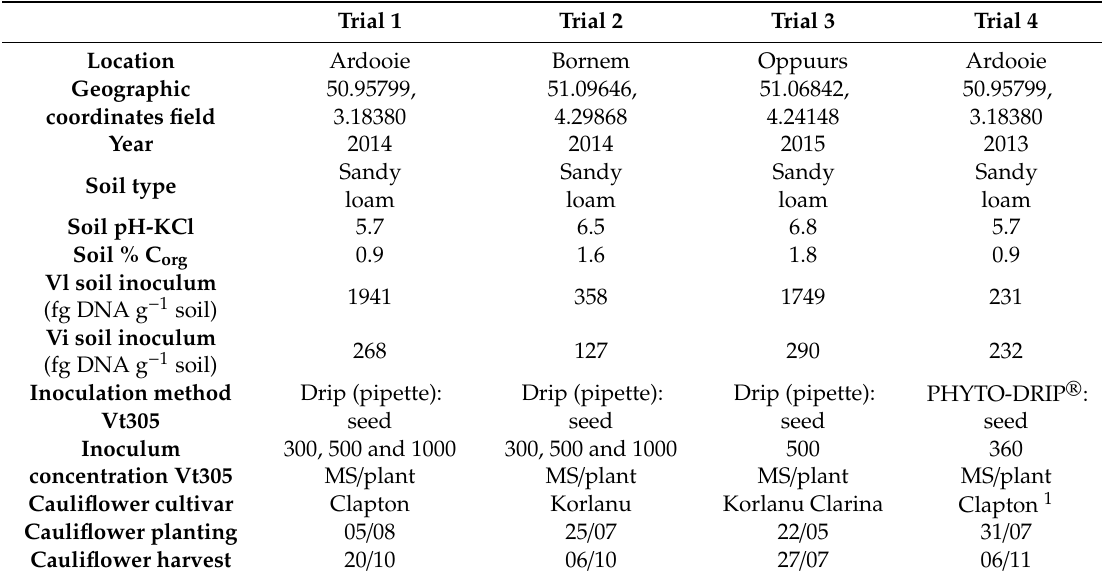
Table 4. Overview of the field trials in which the e ff ect of artificial inoculation of cauliflower plants with V. isaacii Vt305 on Verticillium wilt was tested. For each experiment, the location, the soil characteristics, the amount of soil inoculum of V. longisporum (Vl) and V. isaacii (Vi), the inoculation method and inoculum concentration of V. isaacii Vt305 (Vt305), the cauliflower cultivar used, and the planting and harvest date of the cauliflower plants are